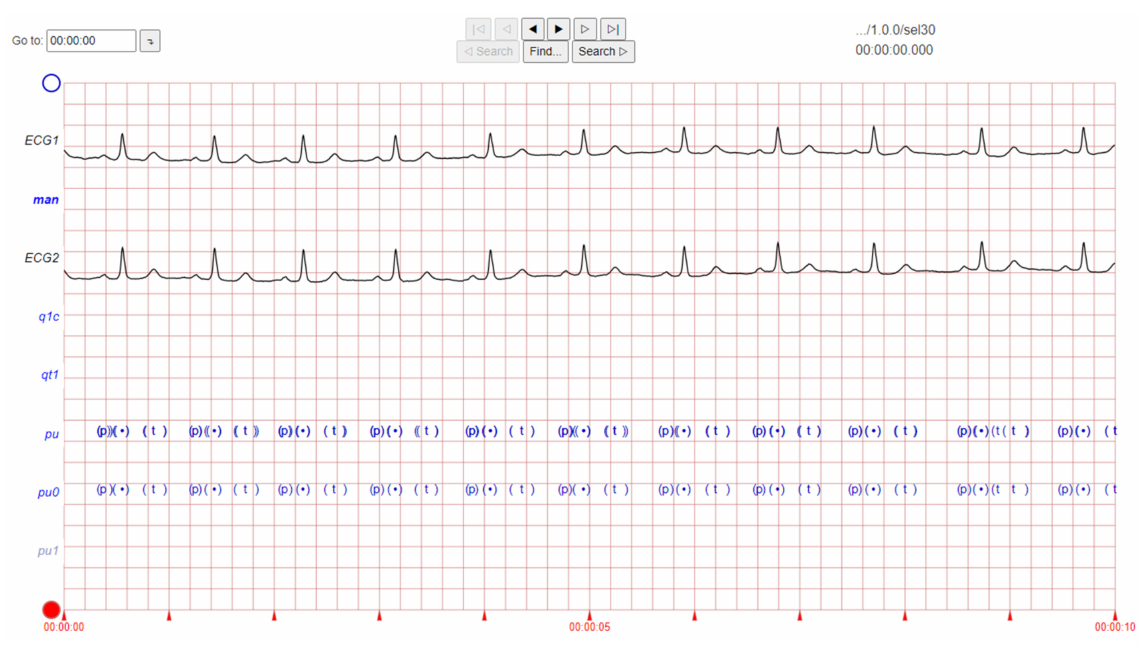
Figure 2. ECG image data for ‘sudden death’